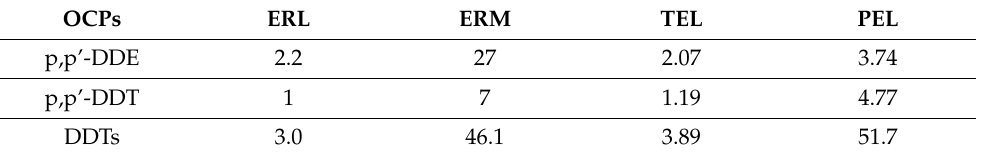
Table 7. USEPA Environmental Quality Standards for OCPs in sediments